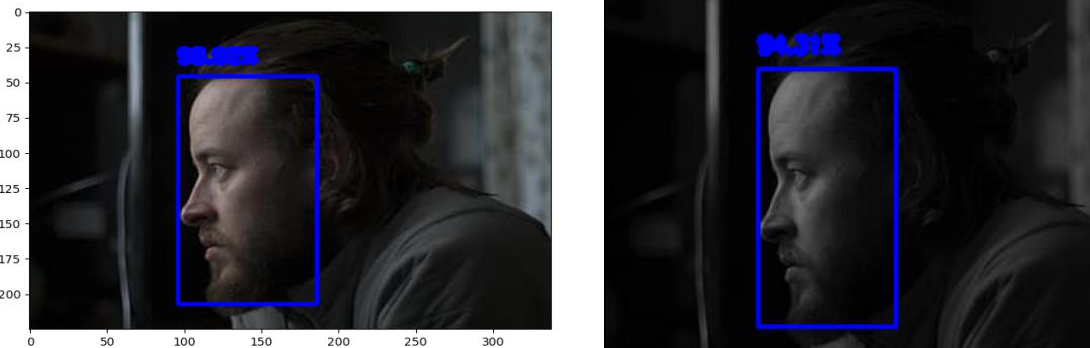
Figure 6 . Result showing face detection in image in low lighting conditions using our proposed model [86].